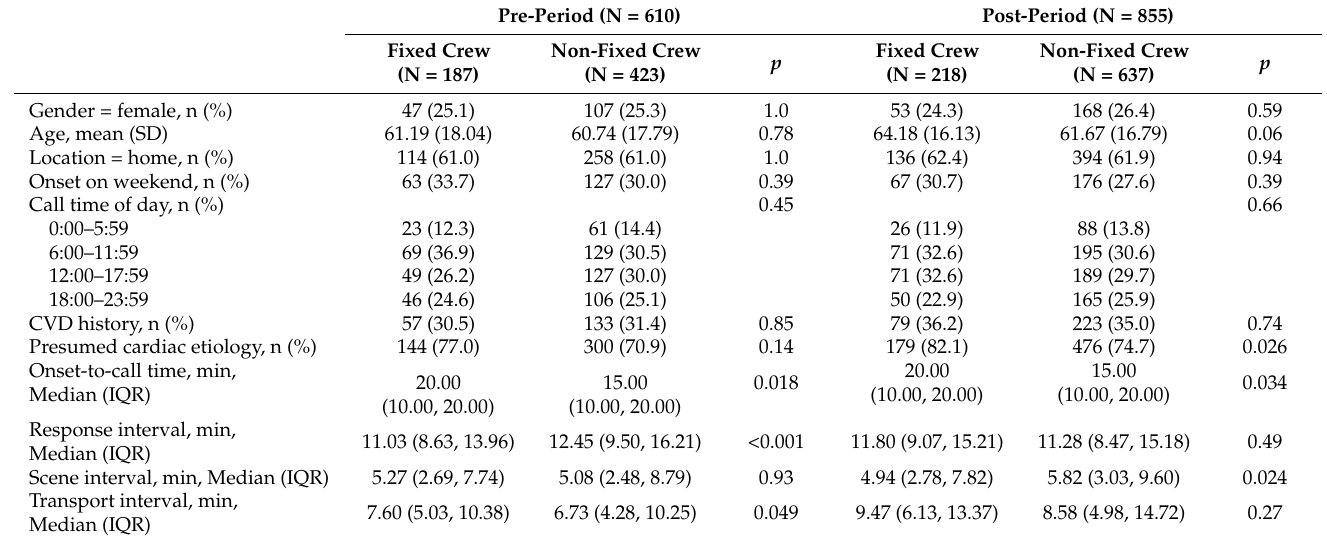
Table 2. Demographics, prognostic factors, and outcomes of OHCA patients treated by fixed or non-fixed EMS stations during the pre-period and